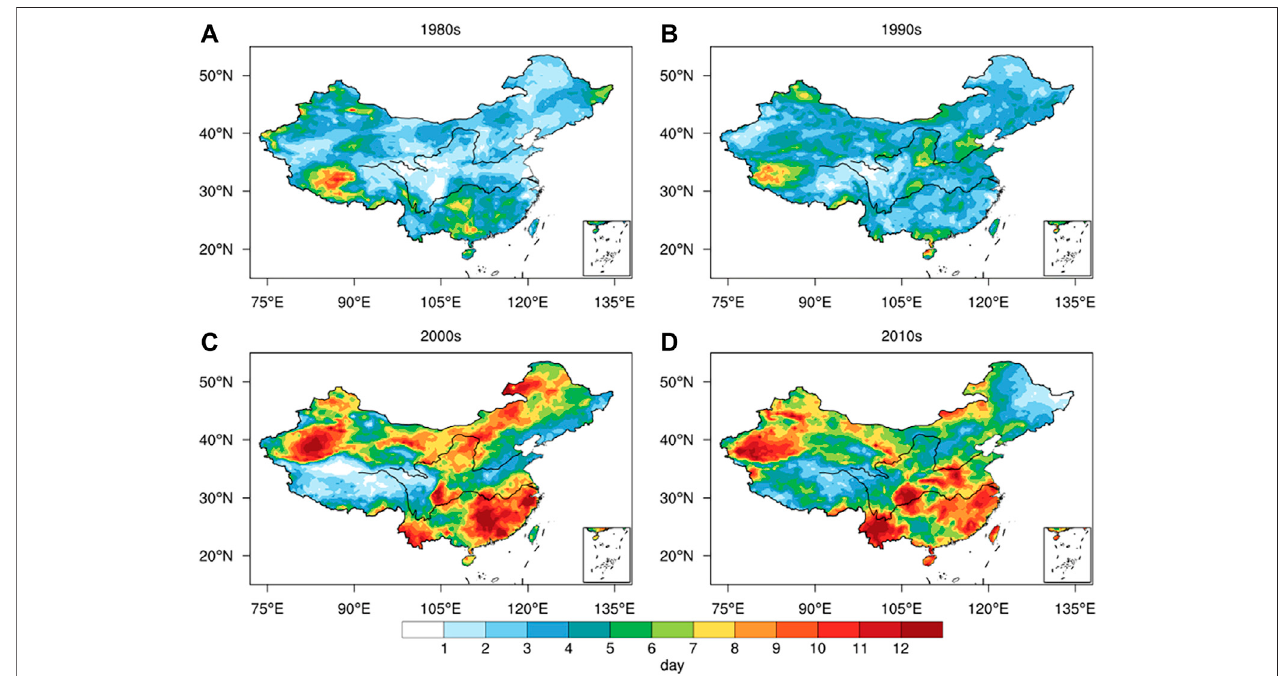
FIGURE 2 | The day numbers of summer CHDEs in the (A) 1980s, (B) 1990s, (C) 2000s, and (D) 2010s (units: day).